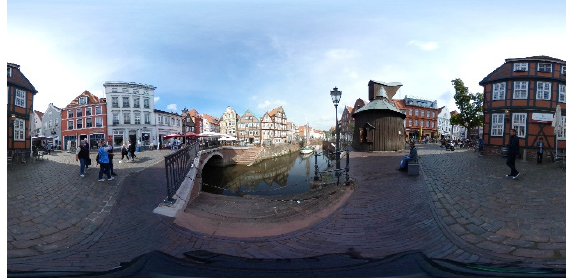
Figure 9. 360-degree panorama photograph taken at the Stade harbour.